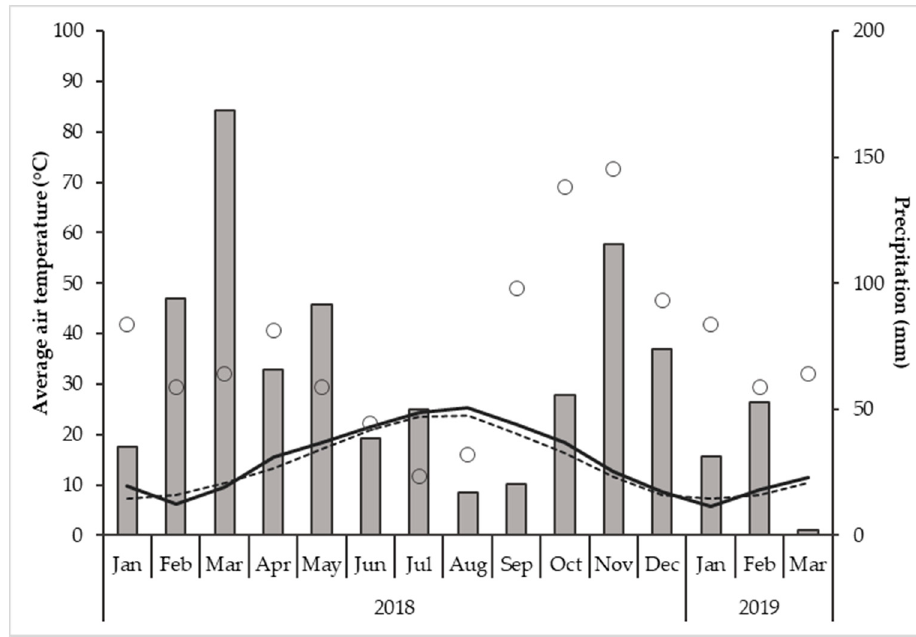
Figure 1. Monthly values for the average air temperature in the study period (solid line) and in the long term (1987–2017, dashed line) and the rainfall in the study period (vertical bars) and in the long term (circular dots). The graph allows dry months, when the precipitation is equal or less than twice the monthly mean air temperature ( p ≤ 2 T), to be identified [54].